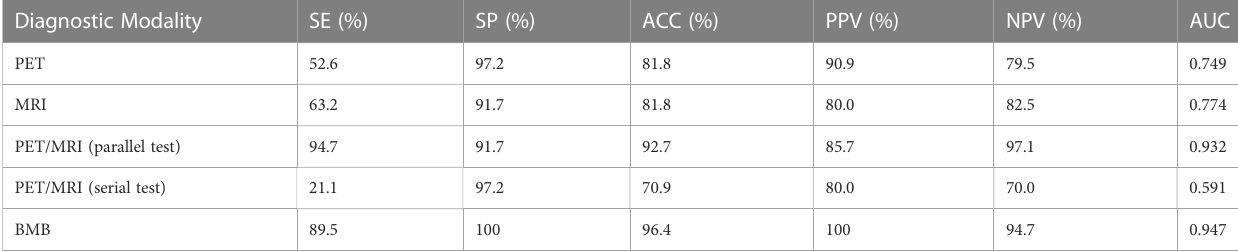
TABLE 3 Diagnostic ef fi ciency of PET, MRI, PET/MRI, and BMB for detecting bone marrow involvement. Diagnostic Modality